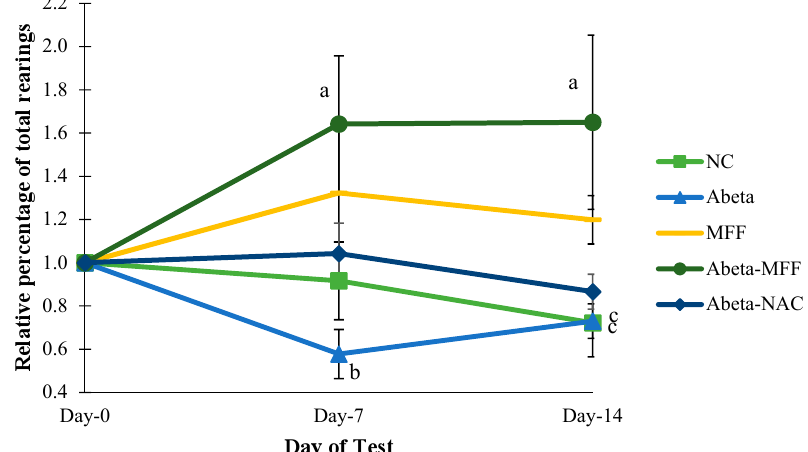
Figure 4. Comparison of the total rearings between the groups on day 0, day 7 and day 14. Every bar represents the mean ± SEM ( n = 5). a p < 0.05 compared to Abeta–MFF on day 0. b p < 0.05 compared to Abeta–MFF on day 7. c p < 0.05 compared to Abeta–MFF on day 14.